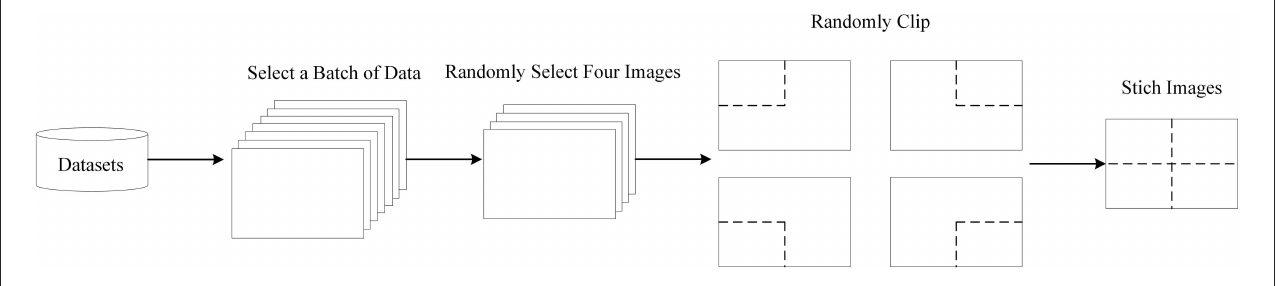
FIGURE3 The procedure of the mosaic data enhancement.